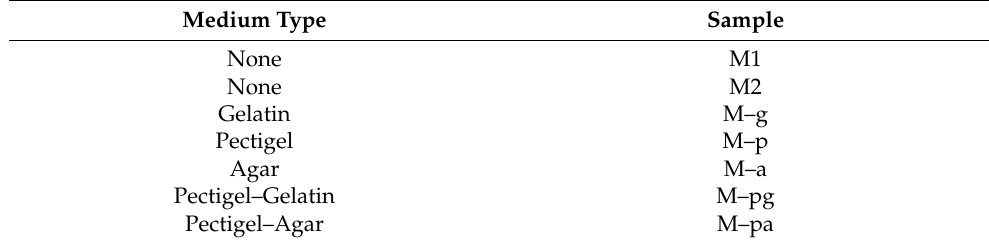
Table 1. Sample nomenclature of the starting